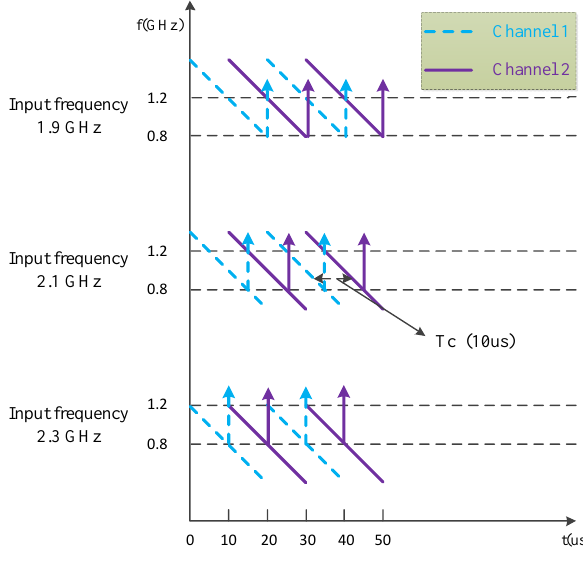
Figure 4. Time–frequency relation schematic diagram of the input frequencies and output pulses of the two-channel